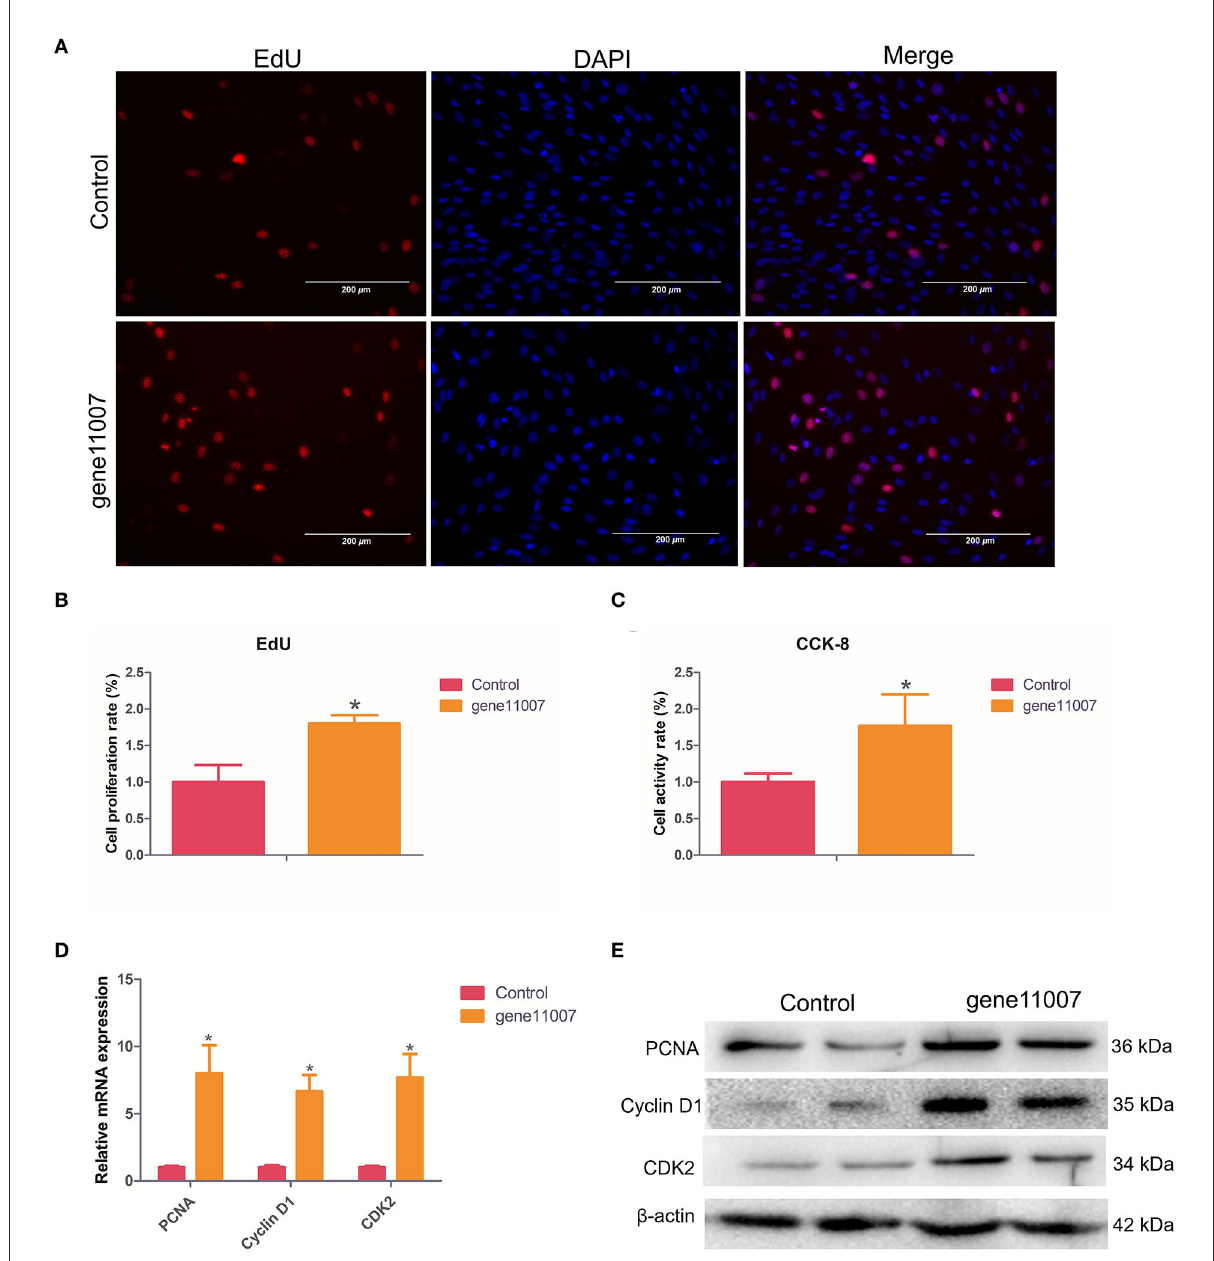
FIGURE9 Assessment of buffalo myoblast proliferation by overexpression of gene11007. (A,B) EdU assays were performed with 5 visual fields for each group. (C) CCK-8 cell proliferation assays, n = 5. (D) Quantitative measurements of mRNA expression of key genes during cell proliferation. (E) Protein expression ofkey genes during cell proliferation. The values are means ± SEMs for three individuals. *represents P < 0.05. The scale bars represent 200 µ